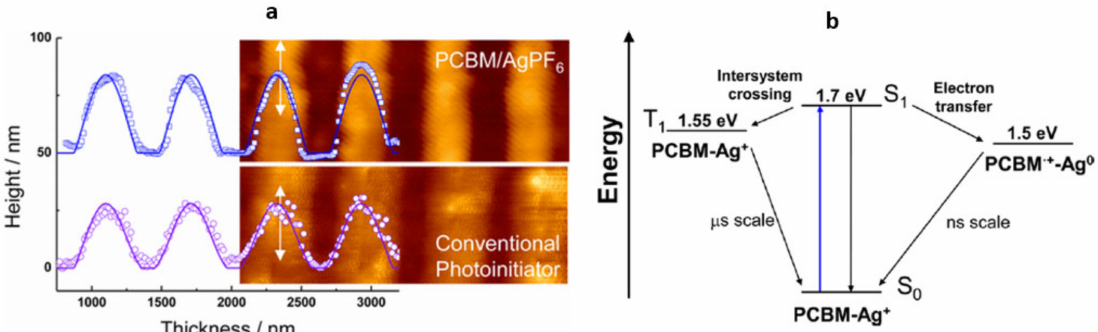
Figure 15. ( a ) overlapped AFM images and height profiles of lines fabricated by MPL in SU-8 using PCBM/AgPF 6 system and conventional PAG. ( b ) Energy diagram and proposed decay pathway of PCBM/AgPF 6 system upon excitation. Reprinted with permission from Ref. [133] Copyright 2017 American Chemical